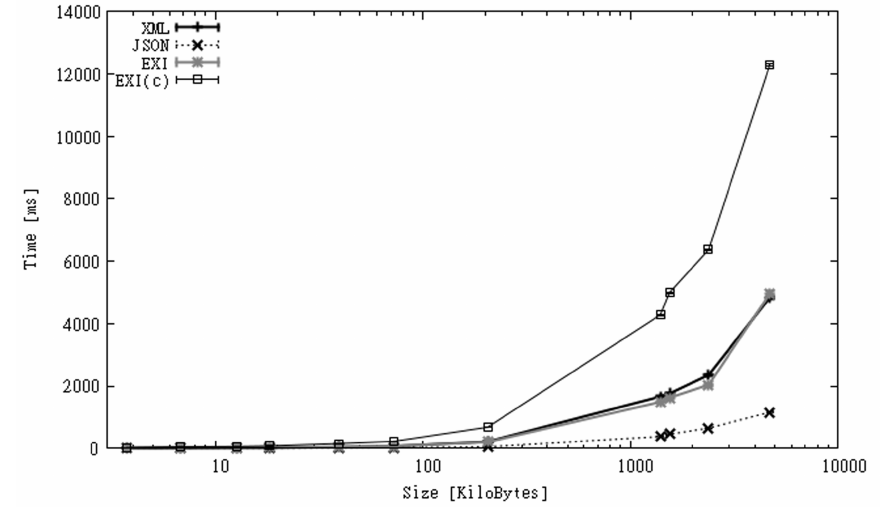
Figure 2. Parsing time for HTC smartphone (CAPS dataset).